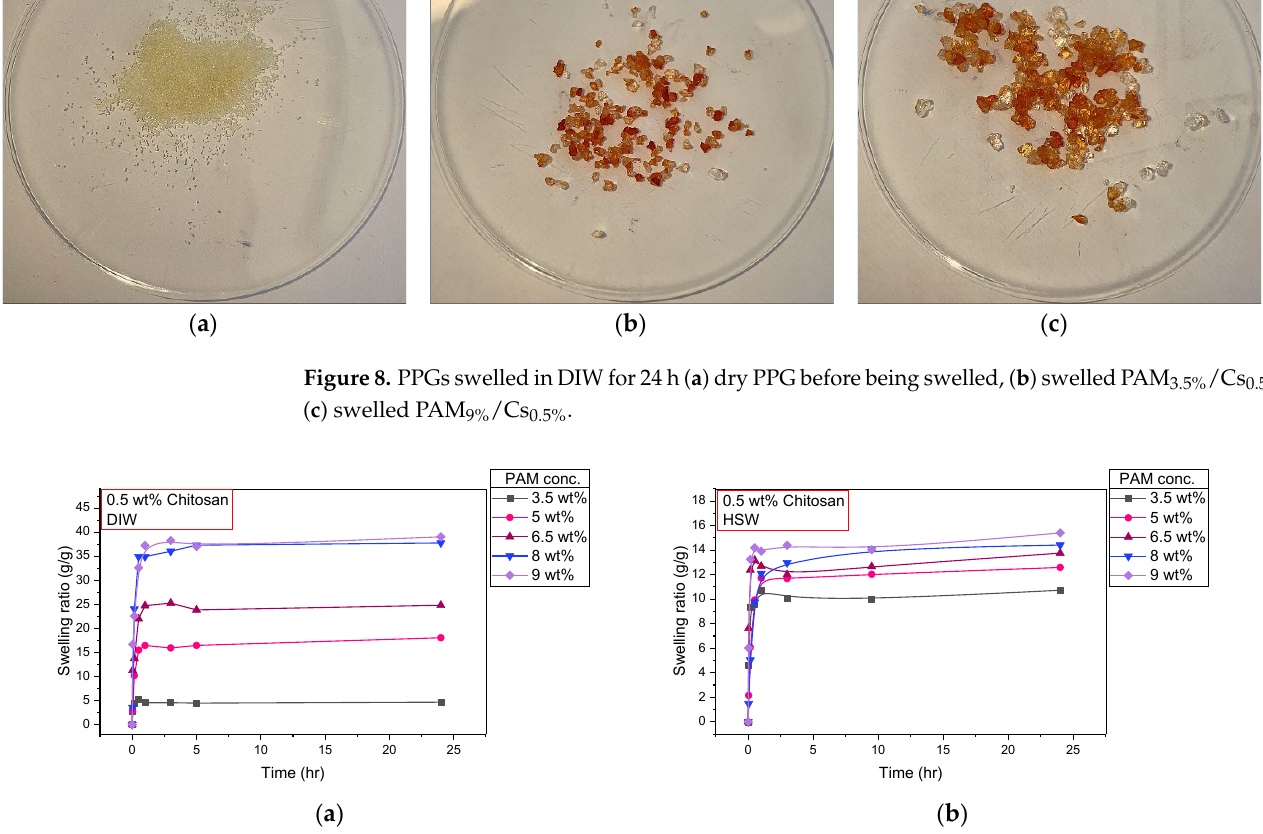
Figure 9. The effect of PAM concentration (3.5 – 9 wt%) on the swelling kinetics in different solution of: ( a ) DIW; and ( b ) HSW.